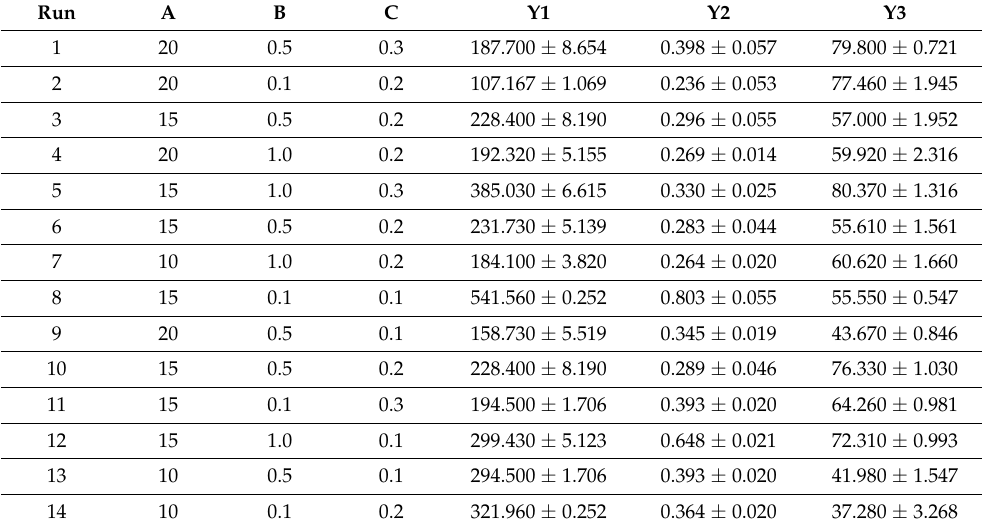
Table 2. BBB designs factors and Observed responses for